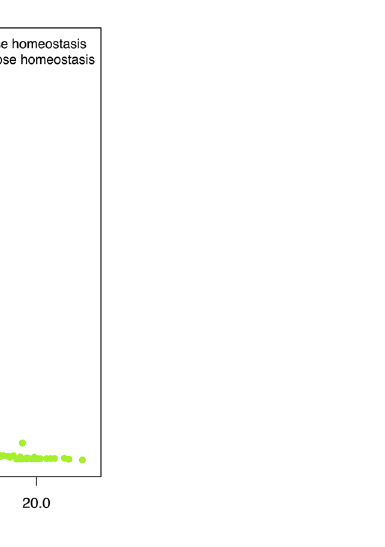
Figure 3. Correlations of SPINA-GBeta and SPINA-GR to waist circumference, fat content and the M value of glucose clamp investigation. p values refer to Spearman’s rho. For greater clarity regression lines of linear models were added together with 95% confidence bands.